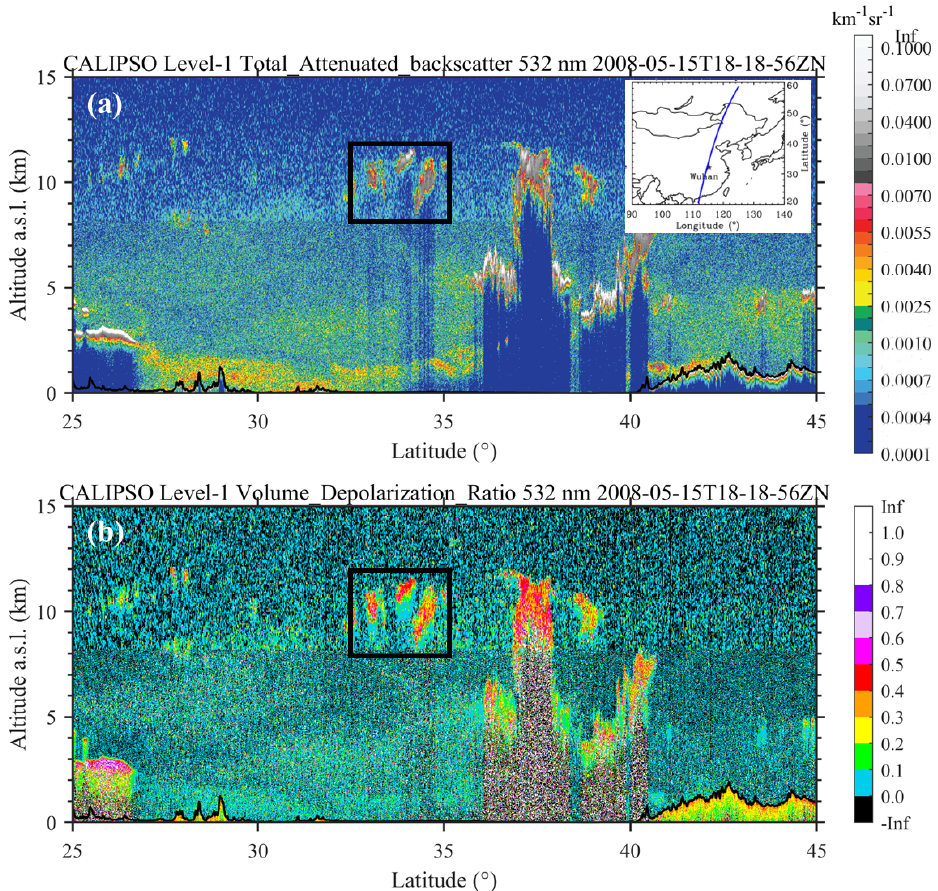
Figure 2. CALIPSO altitude–orbit cross section measurements of the CALIOP Level-1B 532nm (a) total attenuated backscatter coefficient and (b) volume depolarization ratio product on 15 May 2008. The corresponding orbit is 2008-05-15T18-18-56ZN. The black rectangles mark the dust-related cirrus